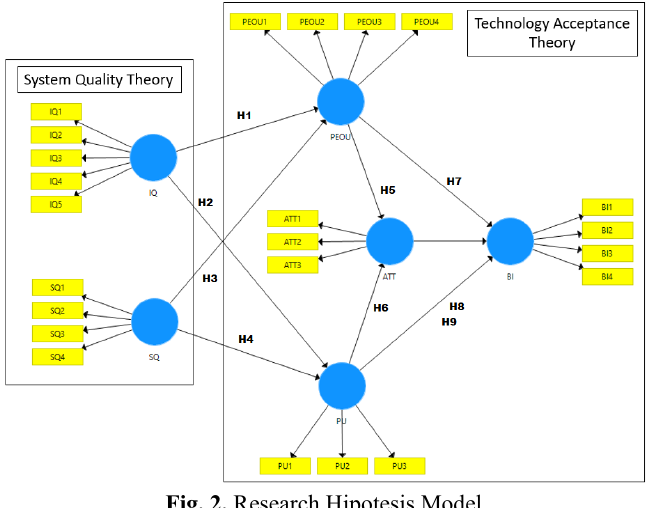
Fig. 2. Research Hipotesis